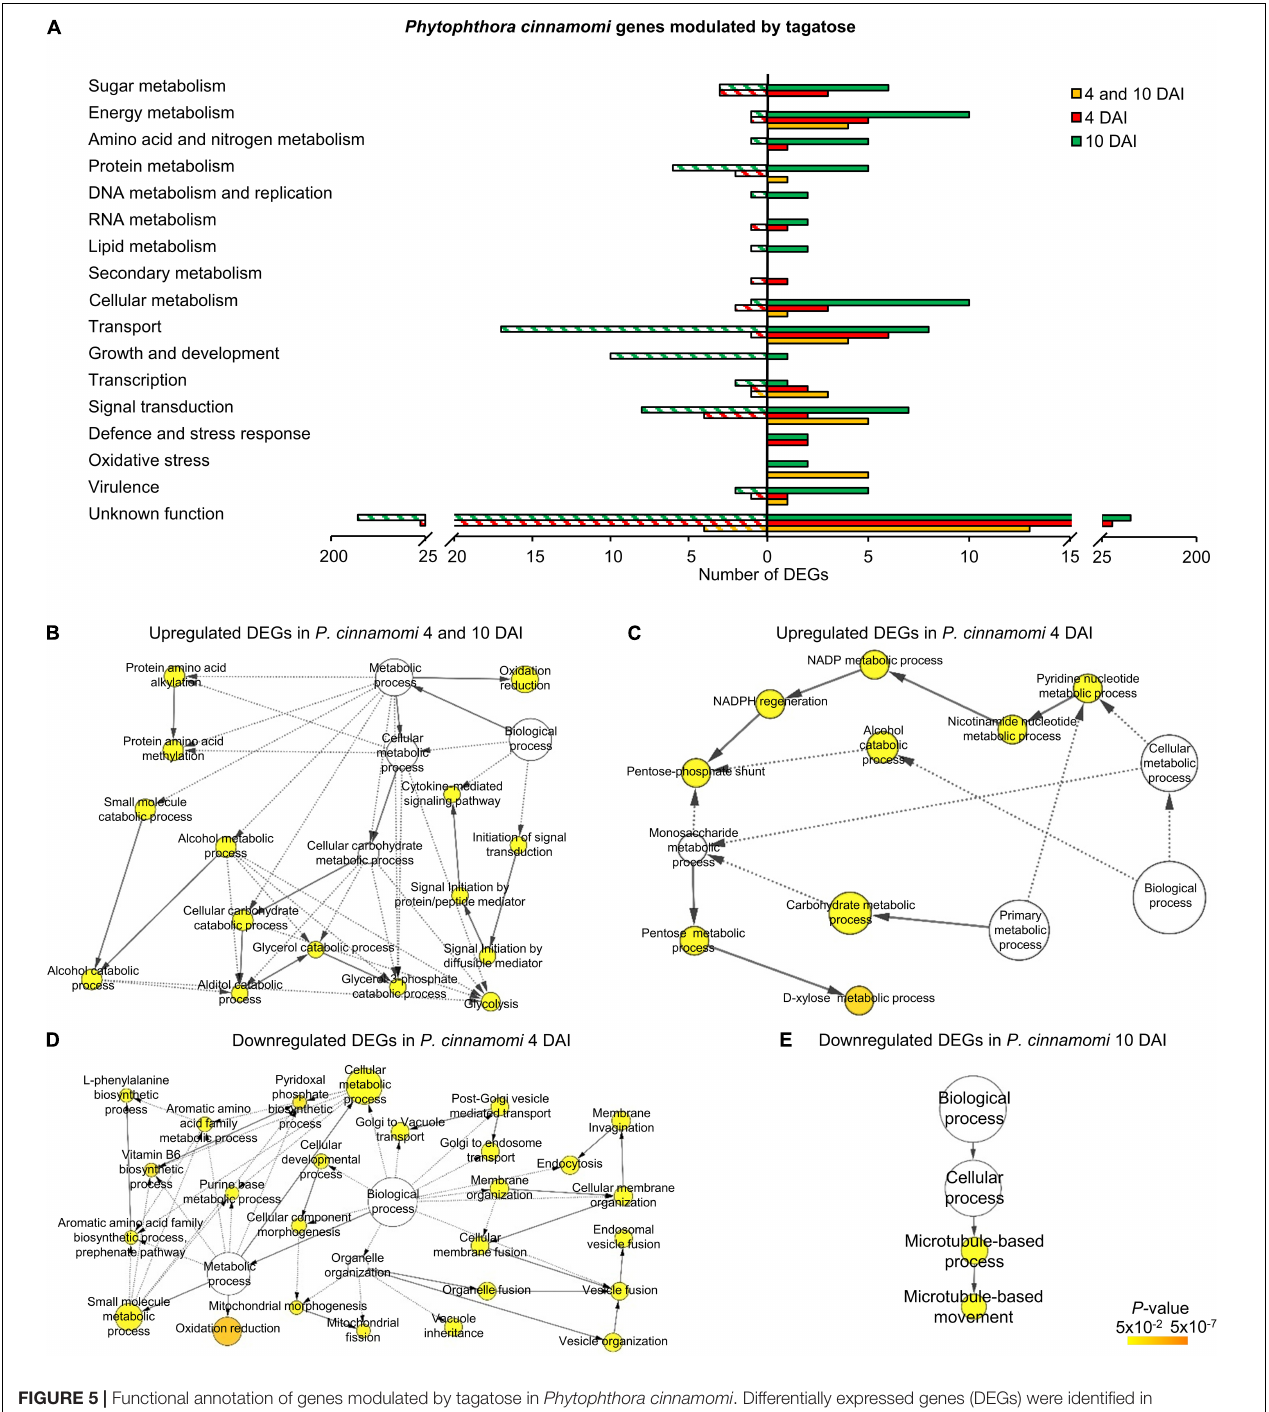
FIGURE 5 | Functional annotation of genes modulated by tagatose in Phytophthora cinnamomi . Differentially expressed genes (DEGs) were identified in P. cinnamomi at 4 and 10 days after incubation (DAI) on pea agar medium in the presence of tagatose compared to the respective control samples grown in the absence of tagatose. Functional categories (A) were assigned based on the protein description of upregulated (solid bars) or downregulated (stripped bars) genes at both time points (4 and 10 DAI; orange) and exclusively at 4 DAI (red) or at 10 DAI (green; Supplementary Table 10 ). Biological networks of significantly enriched ( P ≤ 0.05) Gene Ontology (GO) terms of P. cinnamomi genes upregulated at 4 and 10 DAI (B) , upregulated at 4 DAI (C) , downregulated at 4 DAI (D) and downregulated at 10 DAI (E) were identified using the BiNGO tool and visualized with Cytoscape software. The color scale legend indicates the level of significance for enriched GO terms and white nodes indicate not significantly overrepresented categories. Dotted lines indicate connection between biological process categories in the GO chart, where ancestor and child are omitted for simplicity. No significant GO enrichment was found for P. cinnamomi genes downregulated at 4 and 10 DAI and upregulated at 10